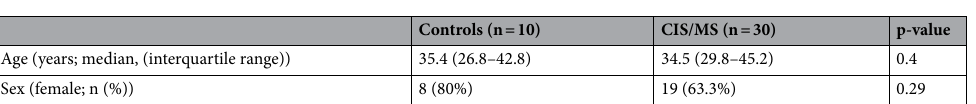
bolded font. Linear regression lines are shown for illustrative purposes only.